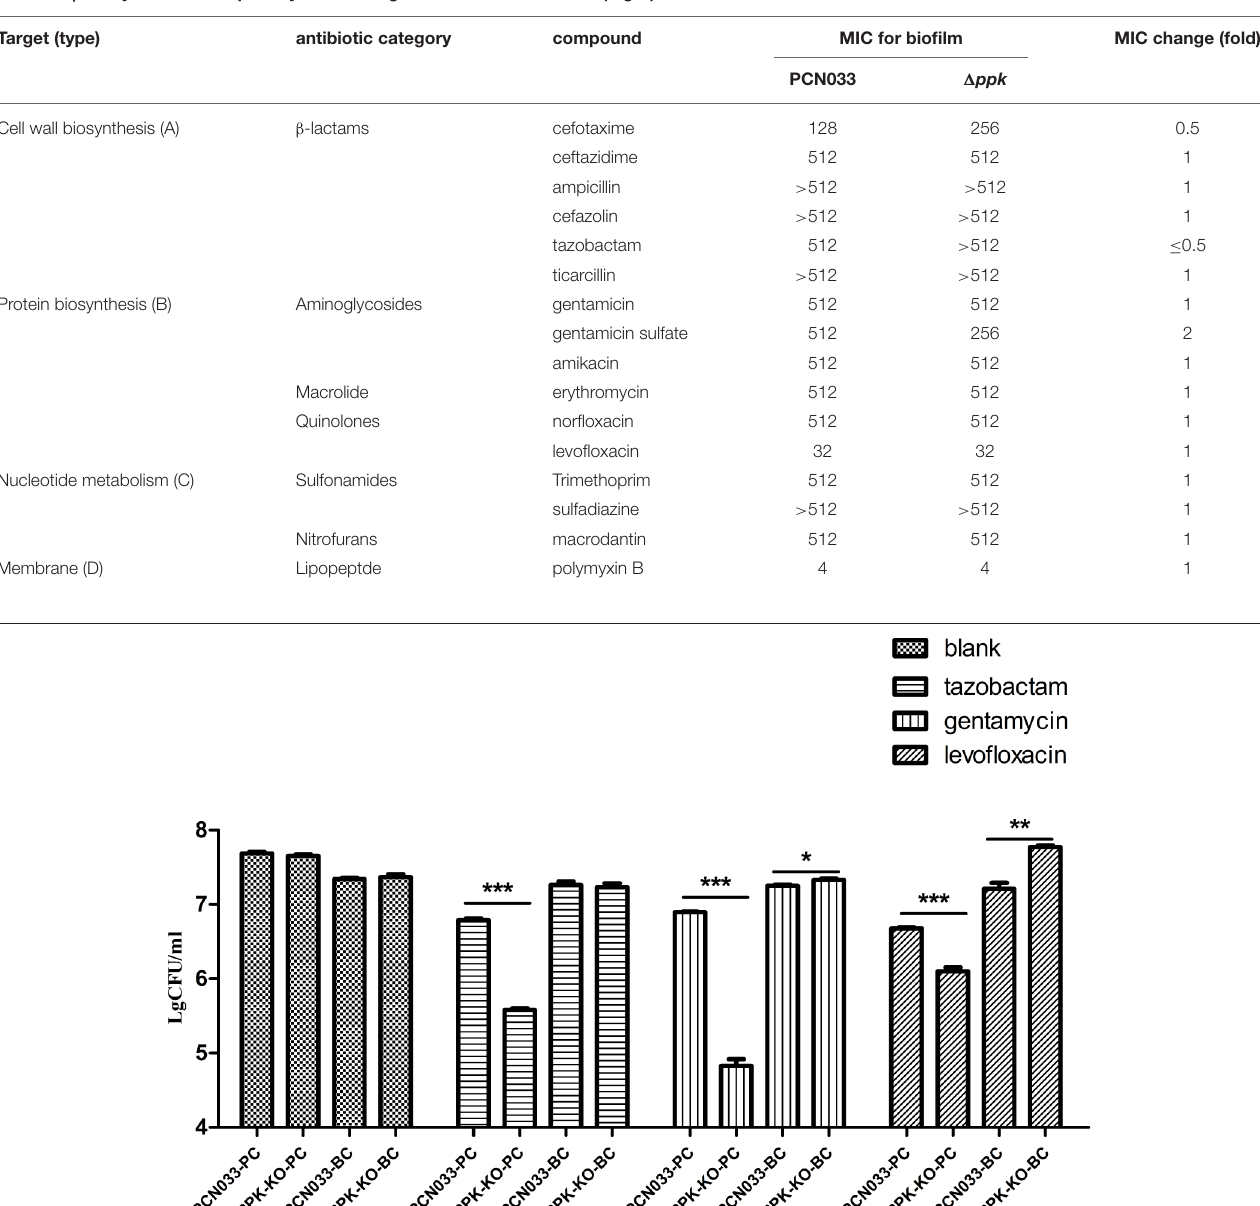
TABLE 2 | Assay of the susceptibility of biofilm-grown cells to antibiotics (mg/L). Target (type)